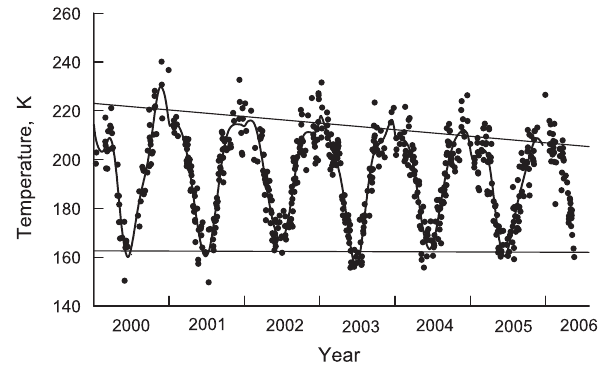
Fig. 3. Hydroxyl midnight temperature (dotes), reconstructed an- nual variations (curve) and regression lines, derived on the base of data for the winter solstice (upper line) and summer solstice (lower